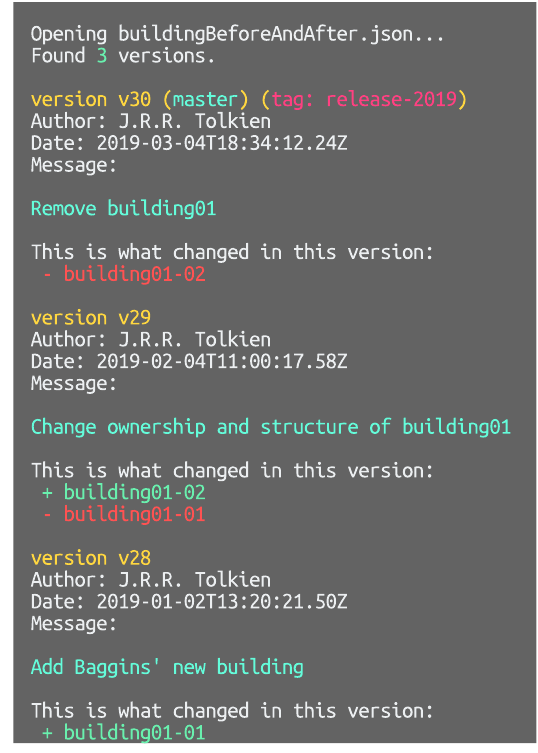
Figure 4. Output of the log operation of our